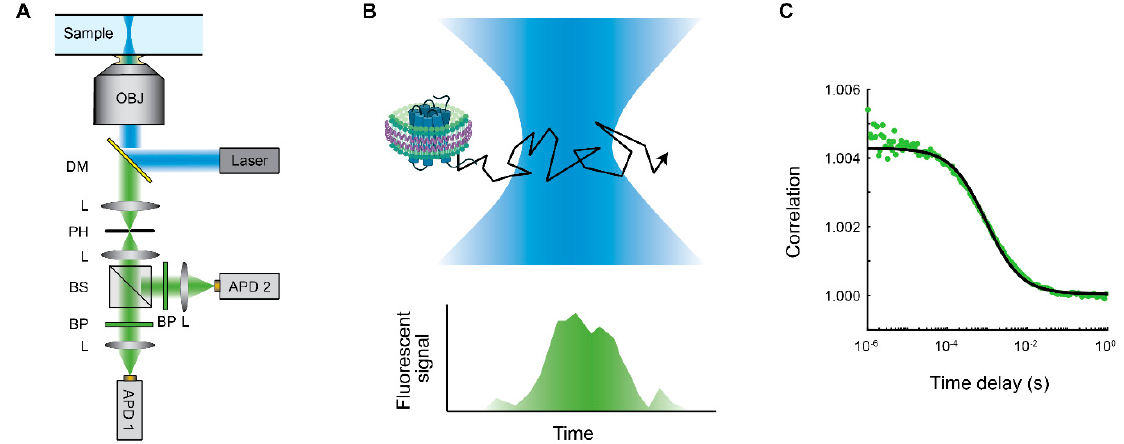
Figure 2. Fluorescence correlation spectroscopy (FCS) applied to membrane proteins embedded in nanodiscs. ( A ) FCS instrument schematic for a single-color system based on a confocal microscope. A tightly focused laser excitation combined with a confocal pinhole define a small, femtoliter-scale open detection volume. The emitted fluorescence signal is typically split and projected onto two detectors to eliminate detector dead time and afterpulsing effects. OBJ: objective; DM: dichroic mirror; L: lens; PH: pinhole; BS: beamsplitter; BP: bandpass filter; APD: avalanche photodiode. ( B ) As a molecule of the fluorescently labeled species, such as the membrane protein embedded in a nanodisc shown, diffuses through the open detection volume, the detected fluorescence signal fluctuates. Size of nanodisc in comparison to laser focus not drawn to scale. ( C ) The g (2) correlation is calculated from the fluorescence signal (green data points). A simple diffusion model (Equation (1)) (black line) is fitted to the data, giving the diffusion time and concentration of the diffusing species. Data shown are of the human β -2 adrenergic receptor conjugated with the green fluorescent protein and embedded inside an Apo-A1 encircled DMPC nanodisc. Fitted diffusion time τ D = 0.92 ± 0.02 ms.